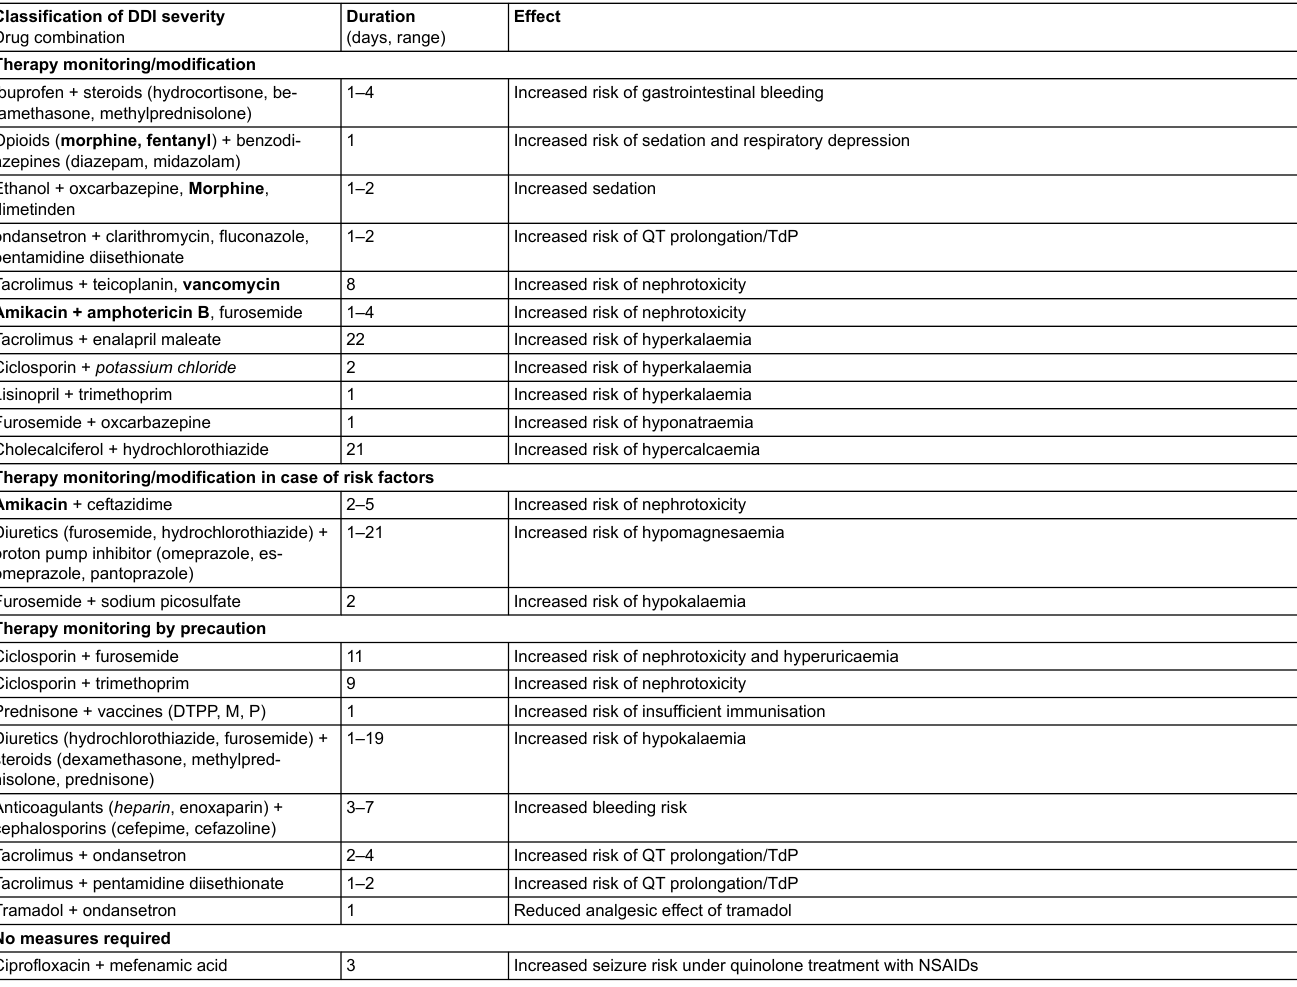
Table 4: Summary of other pharmacodynamic drug-drug interactions (DDIs) issued (not rated as “contraindicated” or “contraindicated by precaution”). Classification of DDI severity Drug